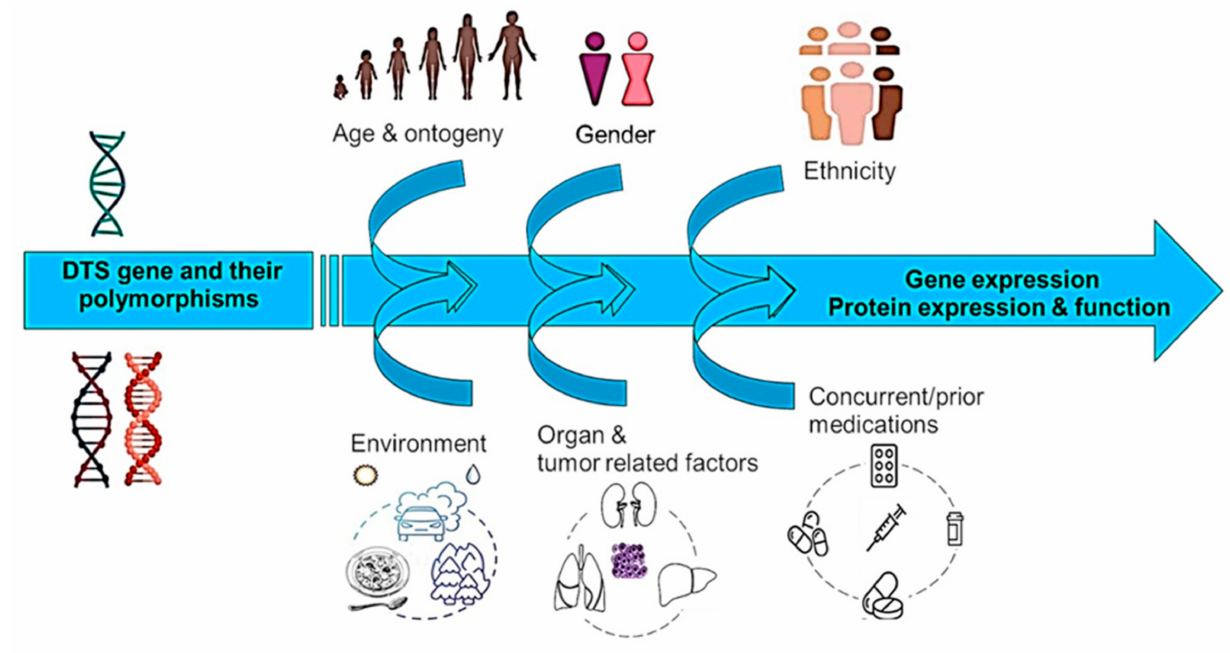
Figure 1. Factors determining expression and function of drug transporters in pediatric